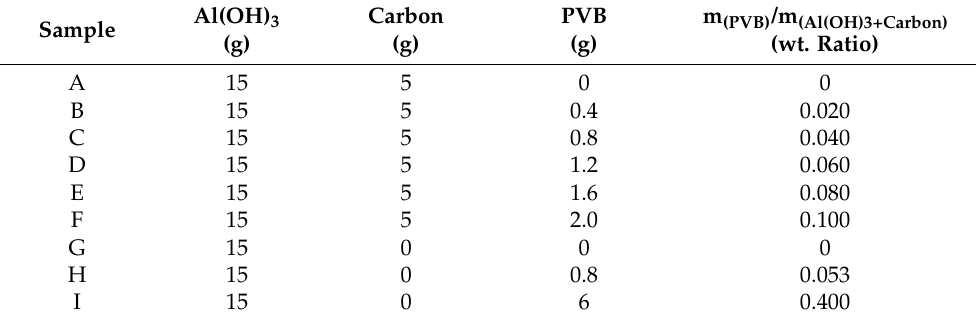
Table 1. Compositions of the different samples with polyvinyl butyral (PVB)